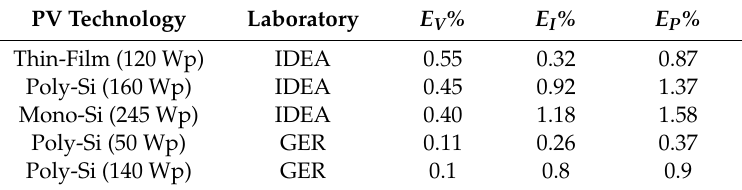
Figure 15. I–V curves obtained simultaneously between the developed tracer and the reference tracer for the monocrystalline silicon PV module. Table 6. Summary of mAximum errors tested in the GER and IDEA